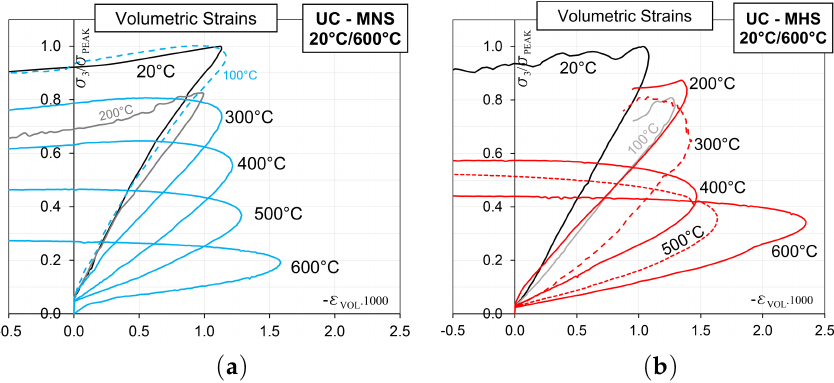
Figure 14. Uniaxial Compression—Mean axial stress vs. volumetric strains curves, normalized in terms of the peak stress at 20 ◦ C for all the considered temperatures for ( a ) MNS and ( b ) MHS.